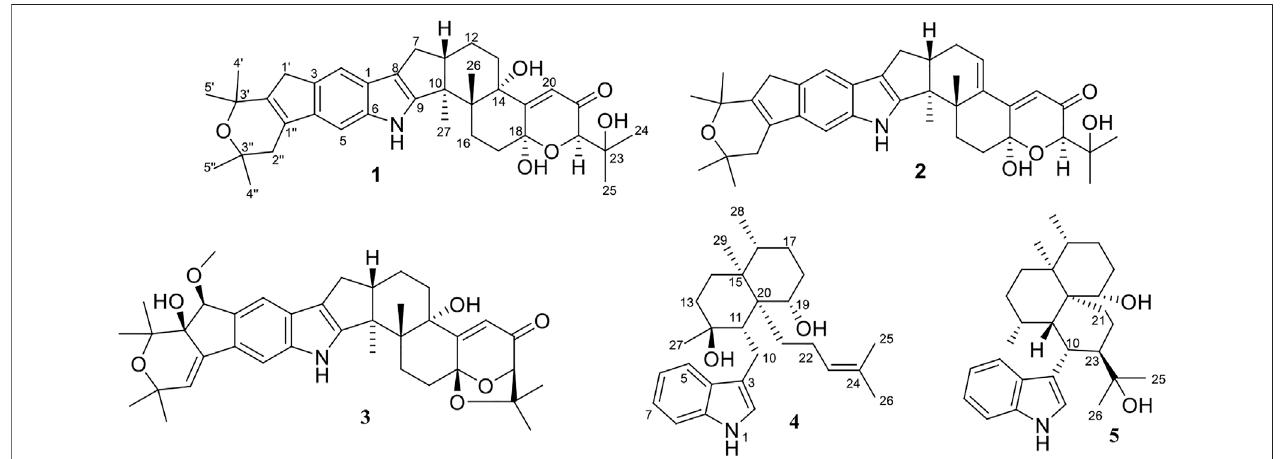
FIGURE 1 | The chemical structures of compounds 1 – 5